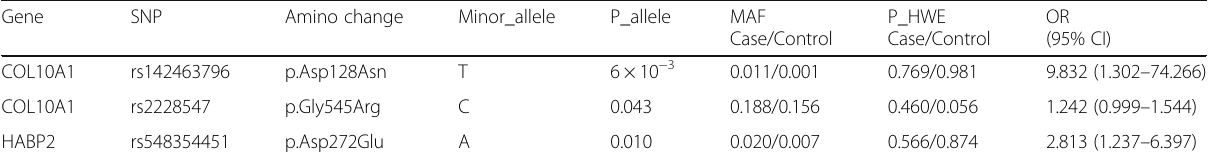
Table 4 Association between the three SNPs within the COL10A1 and HABP2 genes and the presence of KBD revealed in the exon sequencing